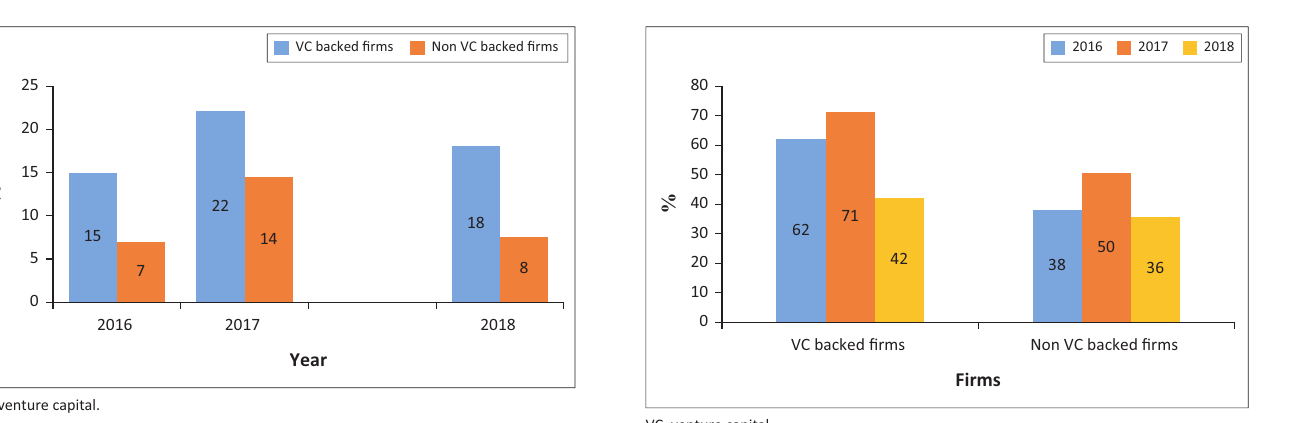
FIG URE 1: Sales revenue growth for the VC-backed and non-VC-backed firms from 2016 to 2018. TABLE 2: The level of significance between venture capital financing (independent variable) and its influence of the sales revenue growth of venture capital-backed firms (dependent variables).